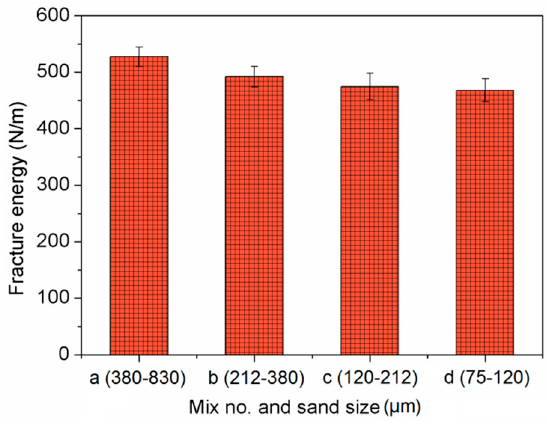
Figure 12. Fracture toughness of cement-based composites.